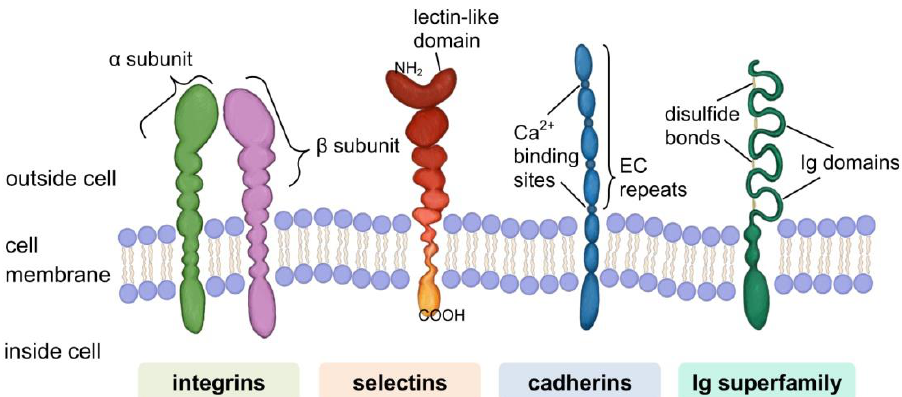
Figure 4. Four families of cell adhesion molecules (CAMs). They are involved in the binding of cells with other cells or with the extracellular matrix in a process called cell with other cells or with the extracellular matrix in a process called cell adhesion.